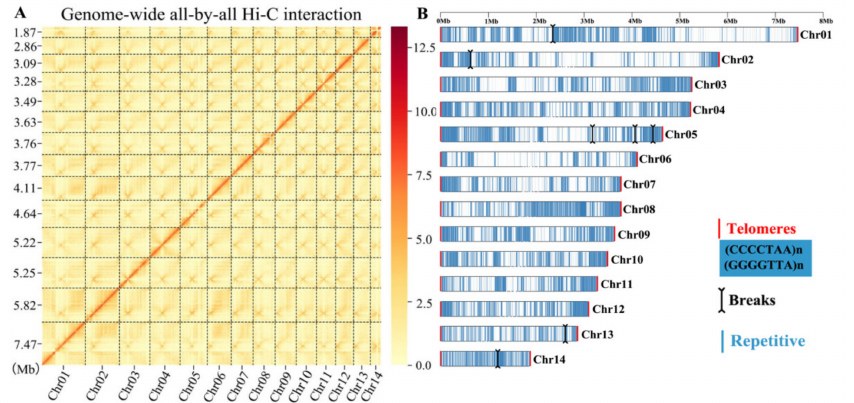
Figure 2. Hi-C interaction heatmap of all bins and chromosome assembly. ( A ) Hi-C interaction heatmap of all bins. The numbers on the left represent the chromosome length. ( B ) Chromosome structures, including the telomeres (red line), breaks (black line), and repetitive sequence (blue line) distributions.